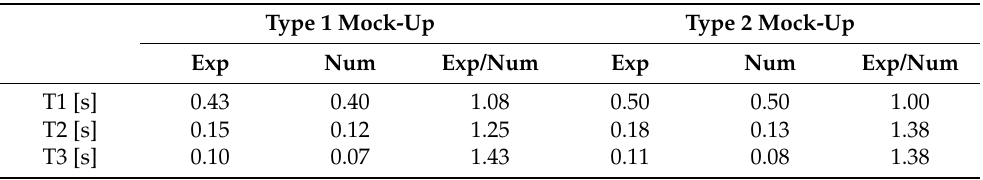
Table 3. Comparison in term of fundamental periods of